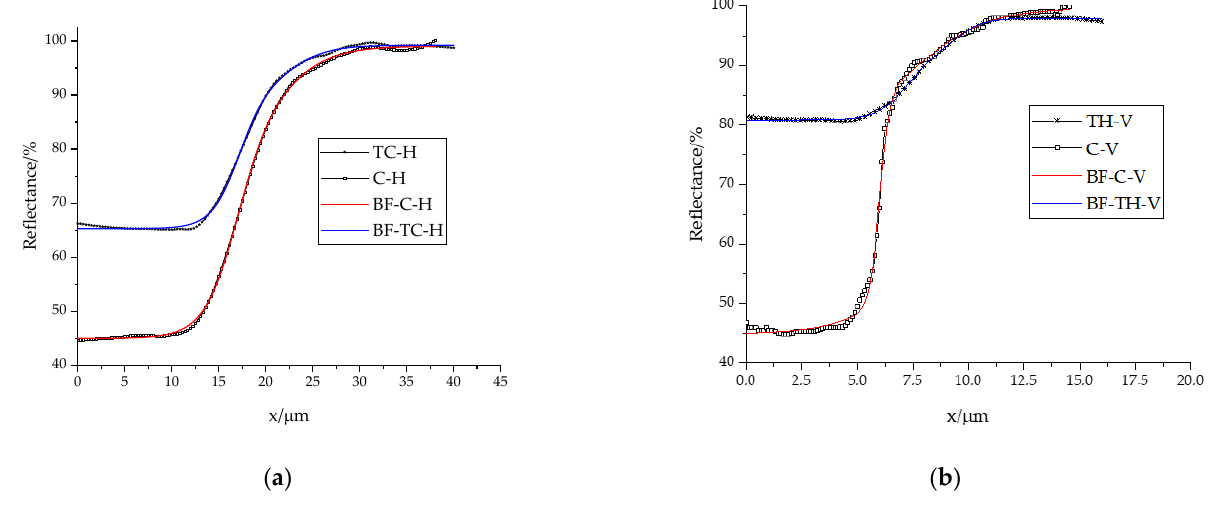
Figure 4. Measured and bi-dose-fitted (BF) reflectance profiles of conventional (C) and thermochromic (TC) prints: ( a ) horizontal edge profiles; ( b ) vertical edge profiles.